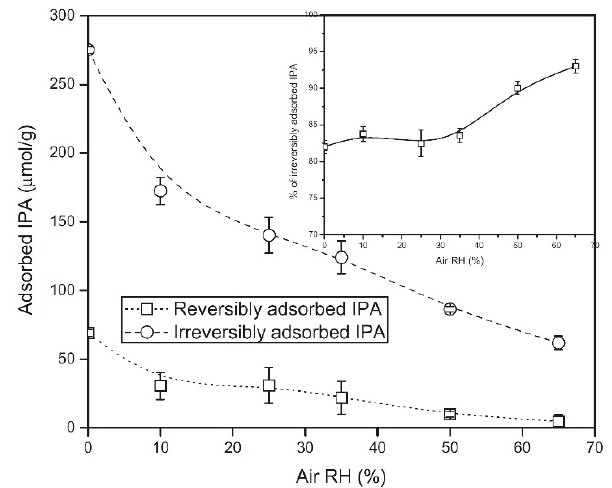
Figure 6. Influence of air relative humidity (RH) on IPA reversible and irreversible adsorbed fractions on TiO 2 at ambient condition. Reprinted from Ref. [35], with permission from